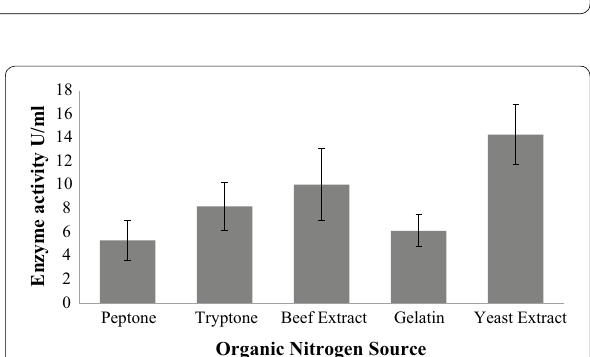
Fig. 4 Effect of organic nitrogen source on keratinase production by Arthrobacter sp. NFH5. The fermentation was carried out at 37 °C with standard pH 7.5 at 150 rpm for 72 h. Data represent the means ± deviations for